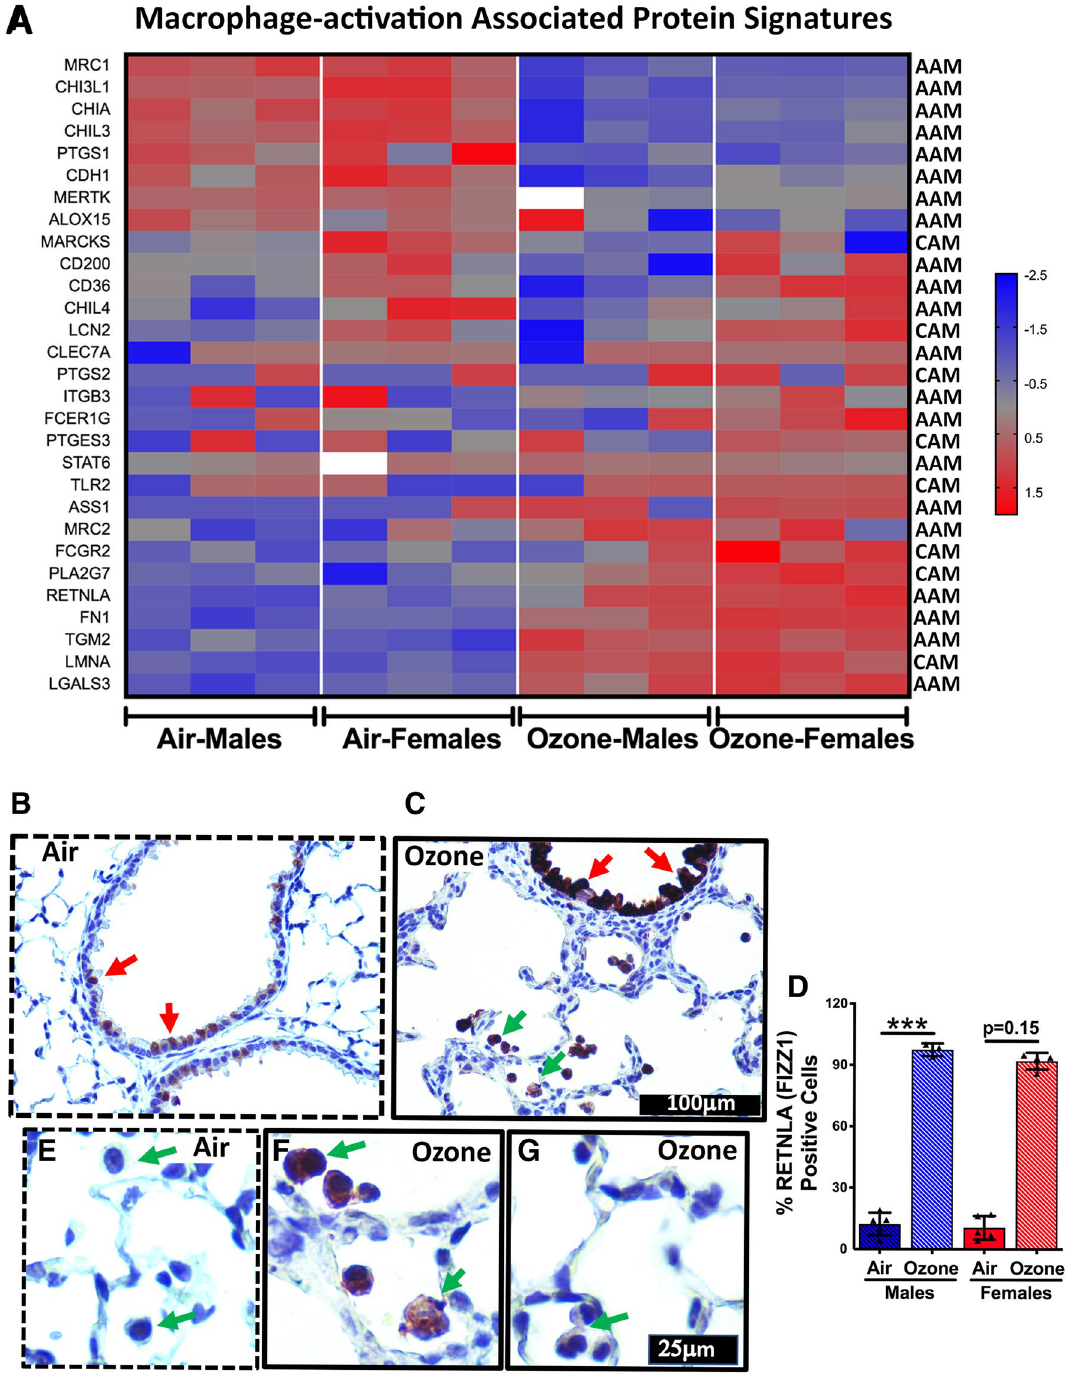
Figure 4. Heat map ( A ) for normalized protein abundance values (Z-scores) representing macrophage activation to classical (CAM, classically-activated macrophages) or alternative (AAM, alternatively-activated macrophages) responses. Higher and lower expressions of each protein are represented by red and blue colors, respectively. ( B-G ) Immunohistochemical analyses of lung sections for cell-specific expression of AAM-associated protein, i.e., RETNLA (FIZZ1). Red arrows point to the RETNLA-stained epithelial cells ( B , air-exposed; C , ozone-exposed). Green arrows point to the macrophages that were positively stained for RETNLA ( C , ozone-exposed). ( D ) Bar graph showing the proportion of epithelial cells in the small airways that were stained positive for RETNLA. Significant main effect was detected (Kruskal Wallis Statistic = 12.27; df = 3; p = 0.0004). Error bars represent Standard Deviation (SD). *** p < 0.001 using Kruskal Wallis test followed by Dunn’s post hoc comparisons (n = 3–5 per group). Green arrows point to the macrophages that remained unstained ( E , air-exposed; G , ozone-exposed;) or those that were intensely stained for RETNLA ( F , ozone-